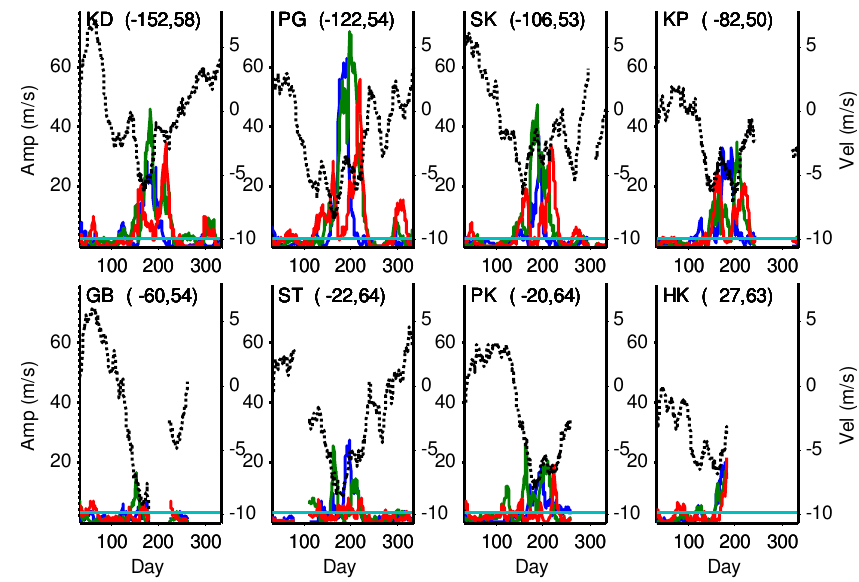
Figure 6. The normalised power spectrum of the meridional 42-h (blue), 48-h (green) and 52-h (red) QTDW components and the meridional mean flow (dotted) for different radars, as indicated by the abbreviations on the top left-hand corner of each panel. The horizontal line represents the 95% confidence level.